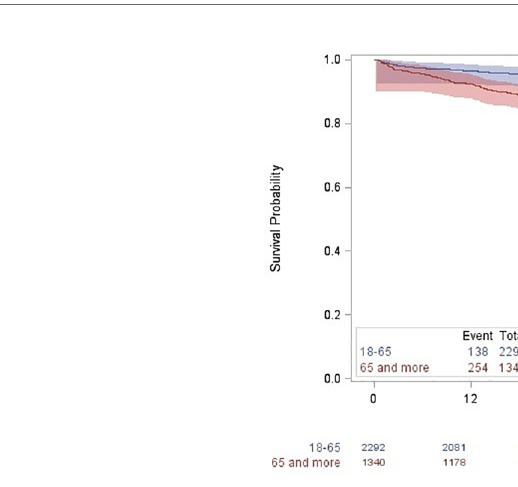
FIGURE 2 | Overall survival probability estimated through Kaplan-Meier curves according to age classes in incident Chronic Myeloid Leukemia (CML) patients identi fi ed in the SNDS between 2011 and 2014 in France. The overall survival rate was signi fi cantly different between age groups, according to the Log rank test.